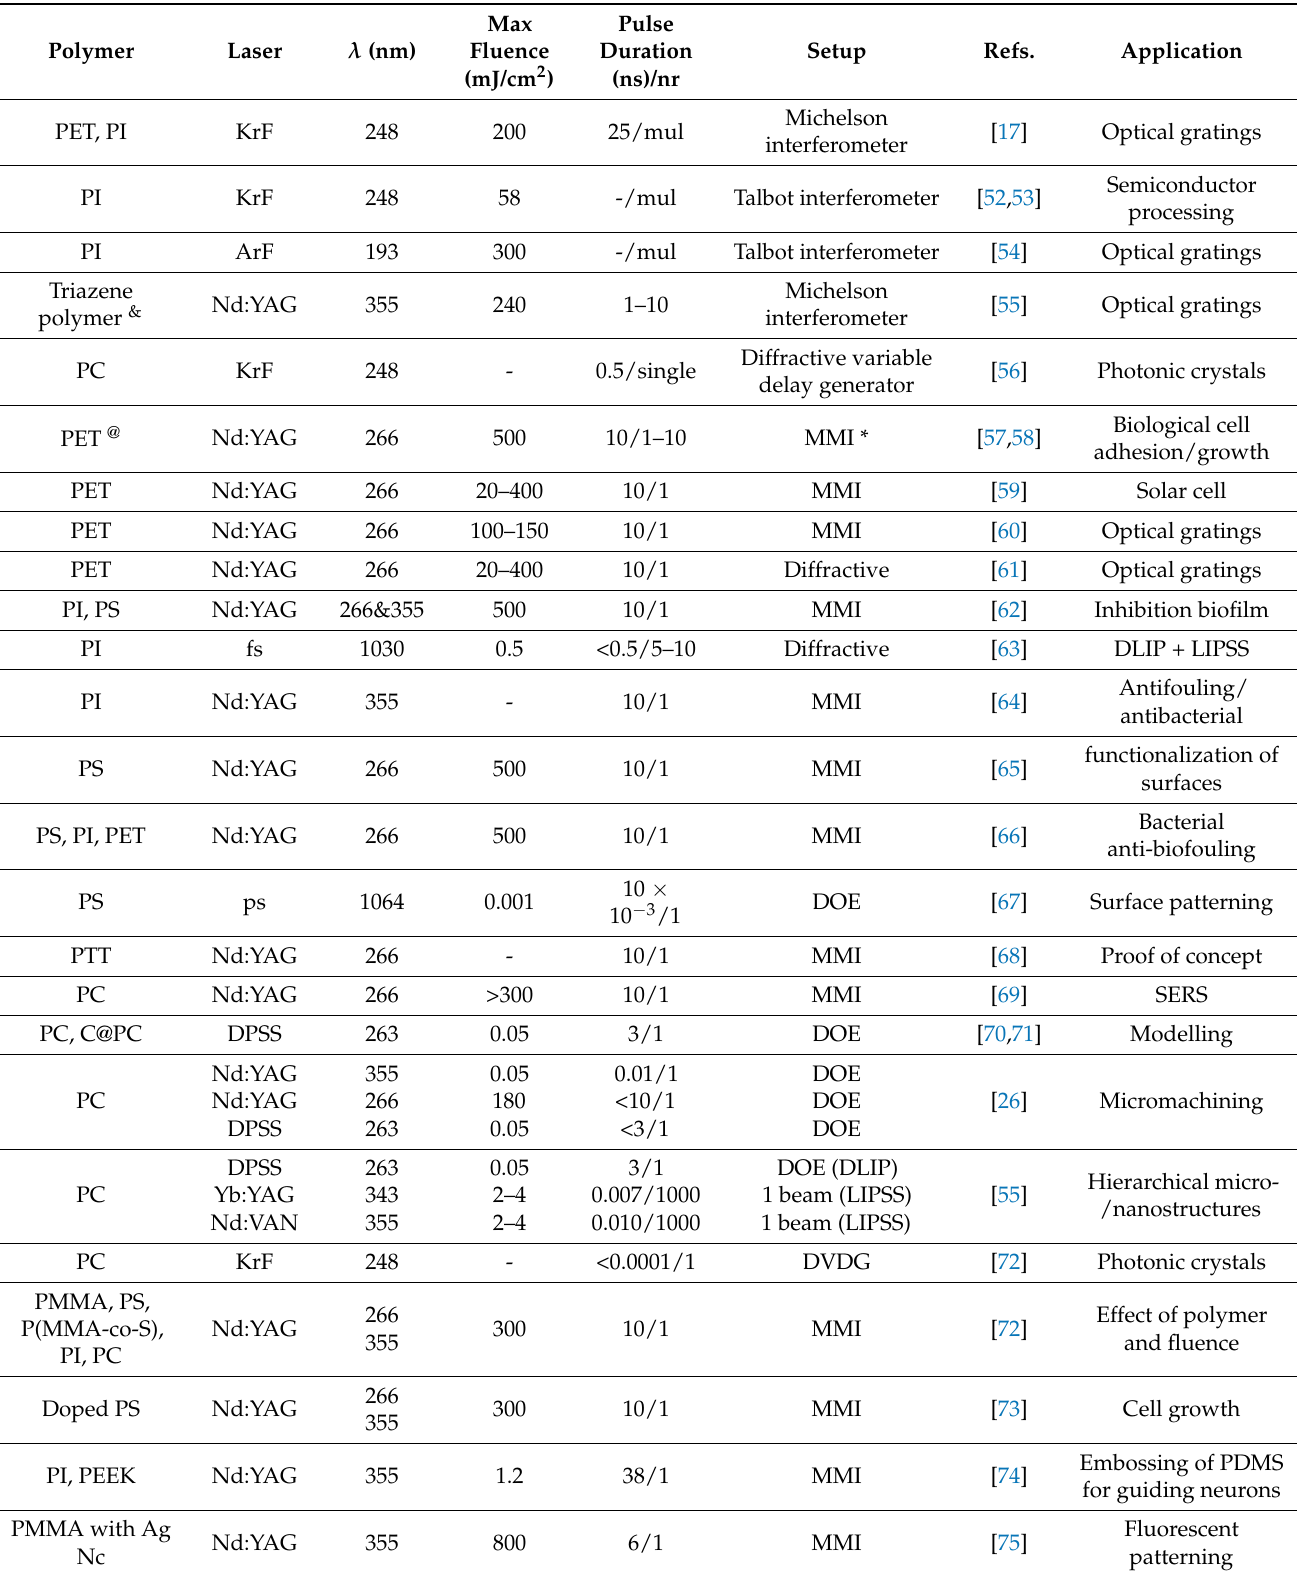
Table 2. Summary of parameters used during DLIP application to